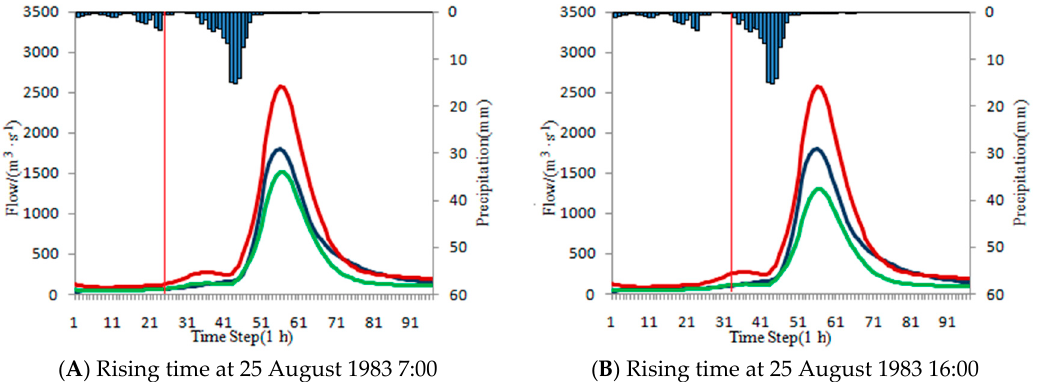
Figure 14. The flood from 24 August 1983 8:00 to 28 August 1983 8:00 in Baizhiao